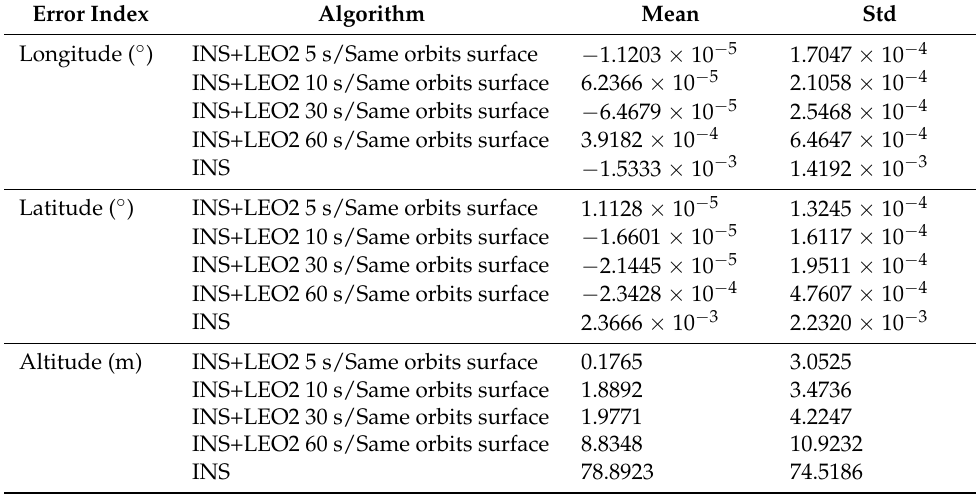
Table 4. The trajectory error